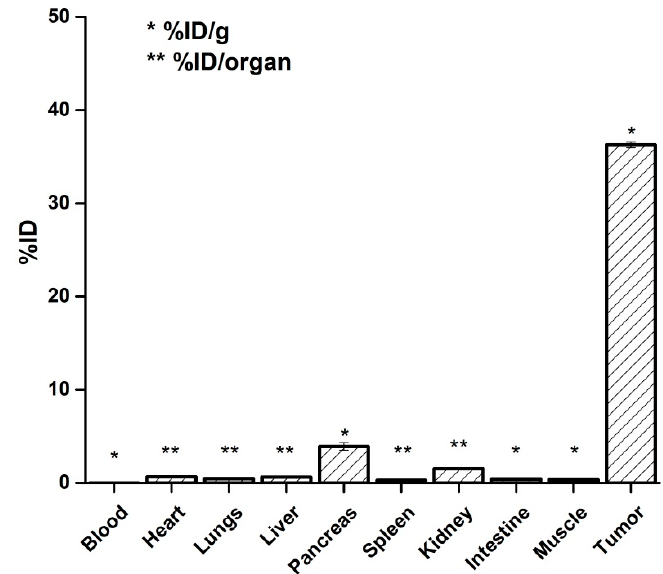
Figure 9. Biodistribution of 177 Lu-DOTA-DN(PTX)-BN 72h post intratumoral administration.